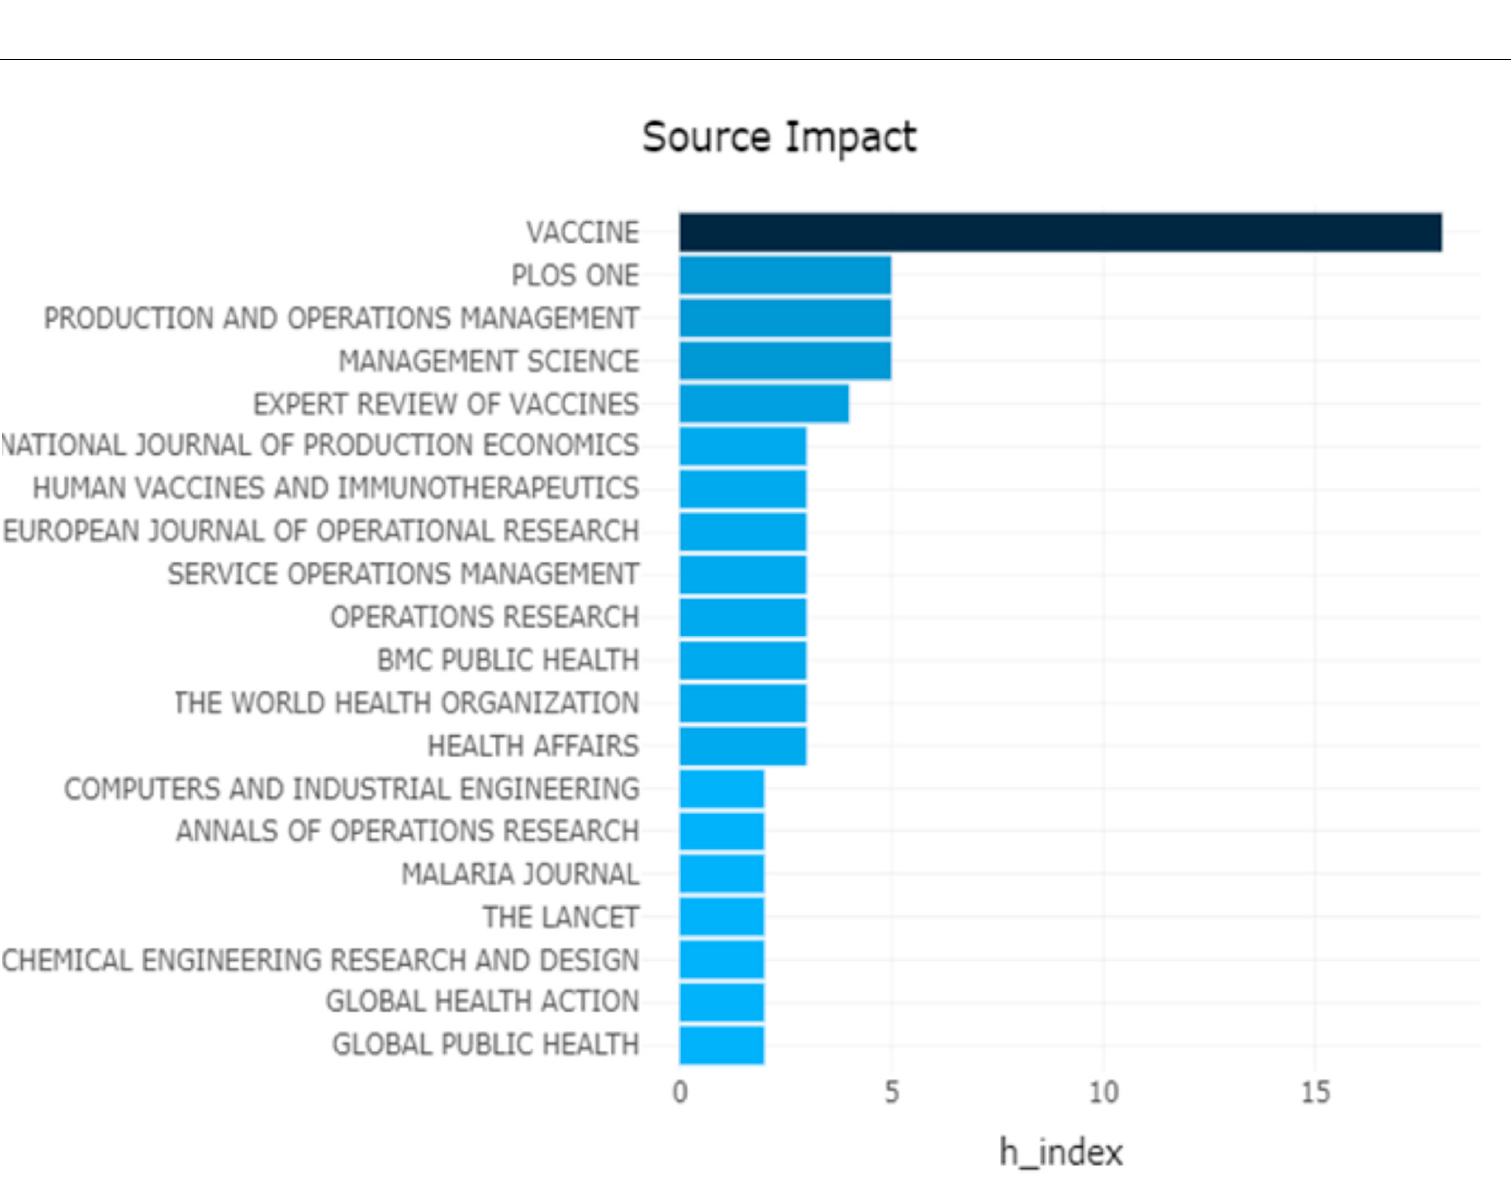
Figure 11. Journal contributions in VSCM.